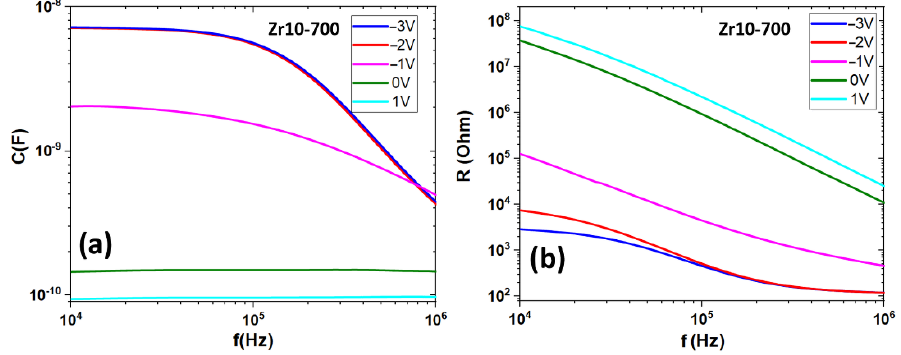
Figure 6. ( a ) C-f and ( b ) R-f measurements made at different voltages applied to the gate oxide elec- trode. oxide electrode.